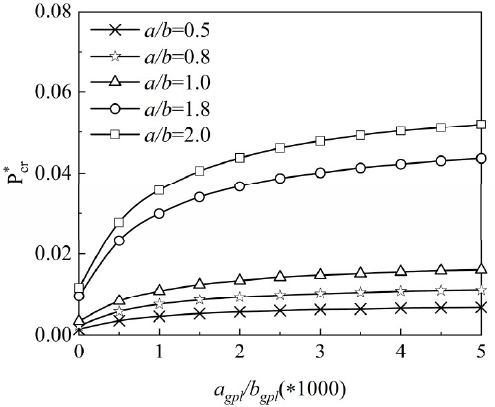
Figure 12. Variation of dimensionless critical buckling load along the graphene length-to-thickness ratio and the side-to-width ratio a/b .